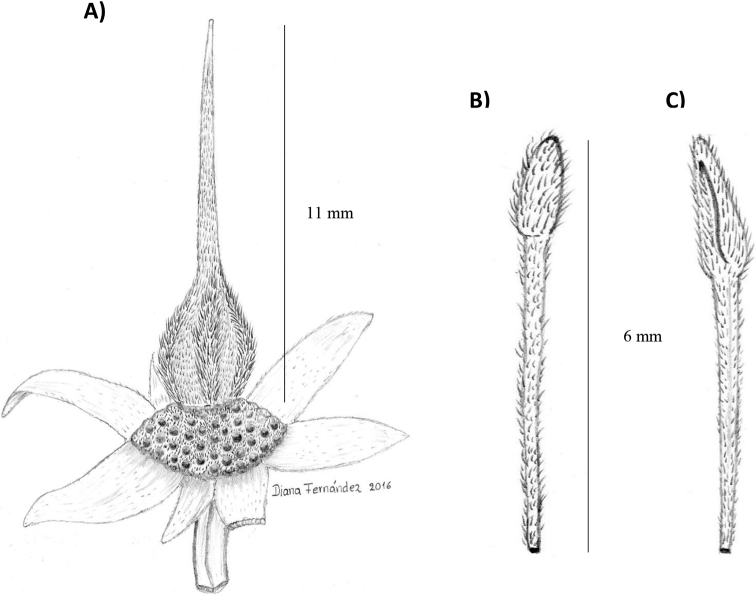
Sloanea
cayapensisA detail of ovary and sepals B dorsal view of stamen C ventral view of stamen (A–C from J. Jaramillo 24200QCA).